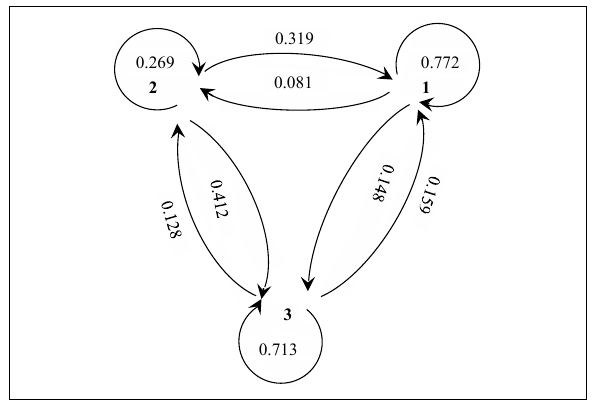
figure 2: Predictions of transition probabilities for the third quarter of